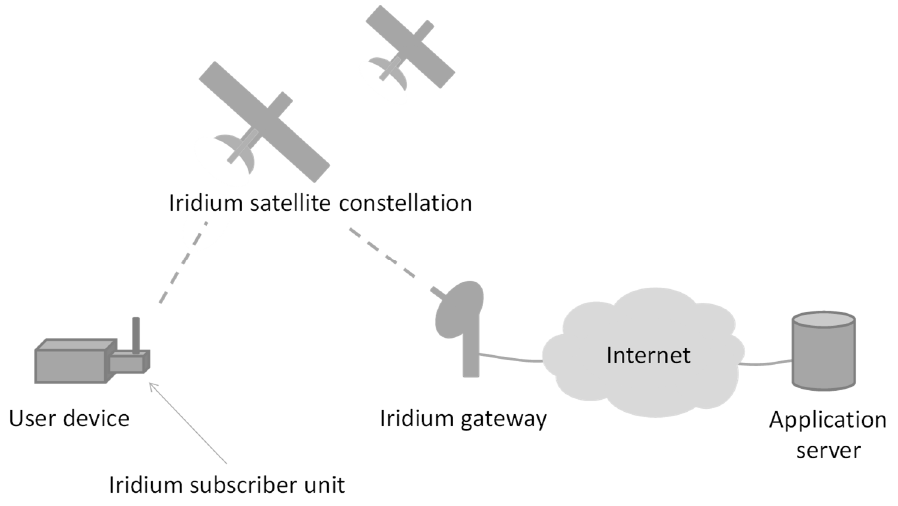
Figure 1. Iridium satellite system architecture.